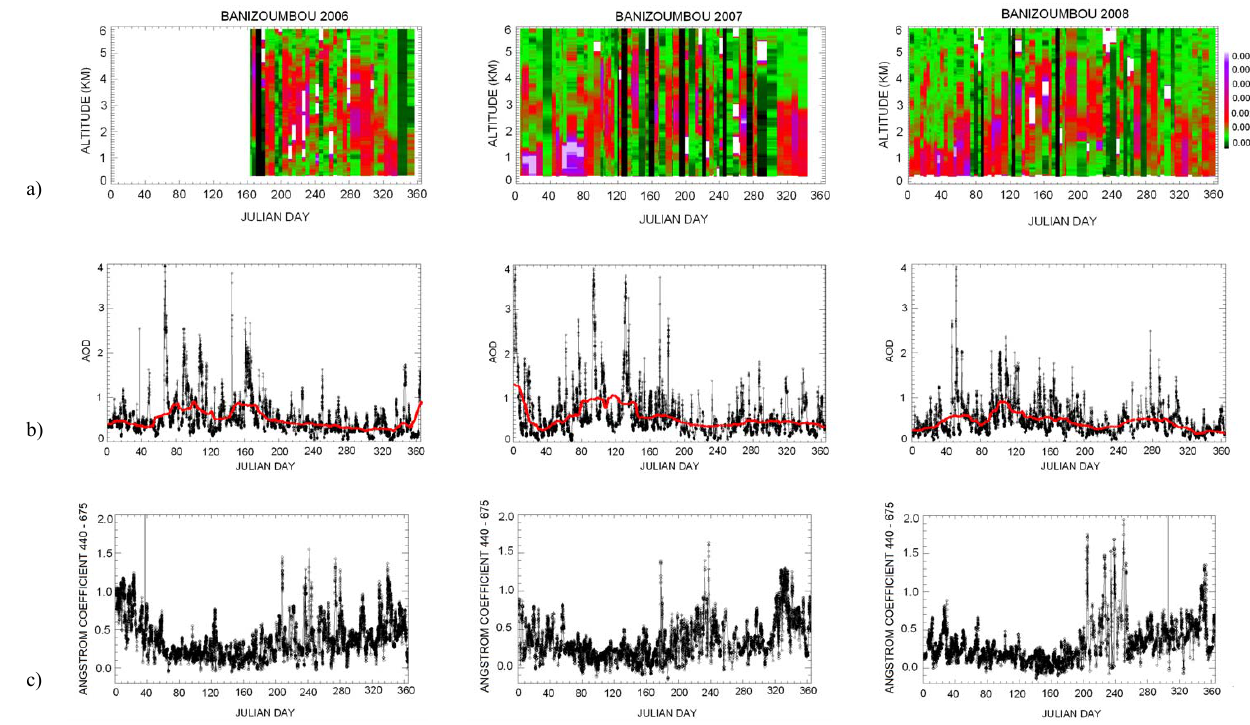
Fig. 3. The total attenuated backscatter (km − 1 sr − 1 ) obtained at 532nm from CALIPSO database (row a ) along with time series of aerosol optical depth (row b ) and ˚Angstr¨om coefficient (row c ) estimated at 532nm from AERONET database for year 2006 (left), 2007 (middle) and 2008 (right) at Banizoumbou site. The red line in (row b ) represents represent a one-month running average of the AOD time series.